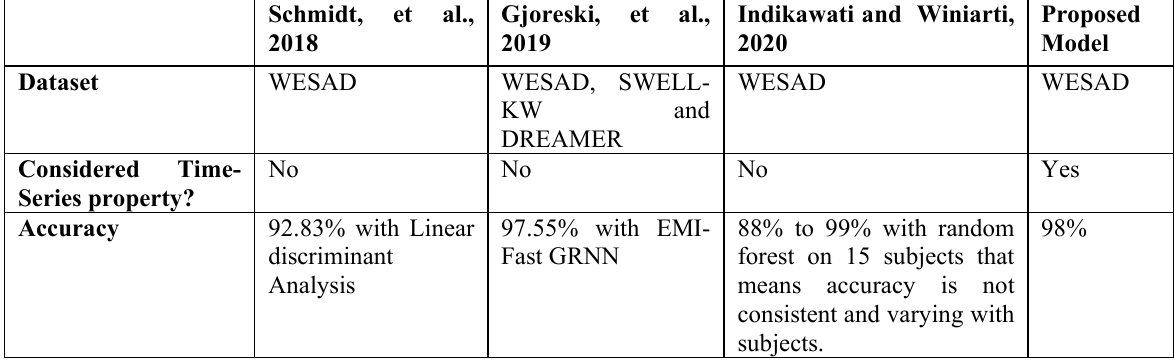
Table 2. COMPARISON OF PROPOSED MODEL WITH EXISTING MODELS